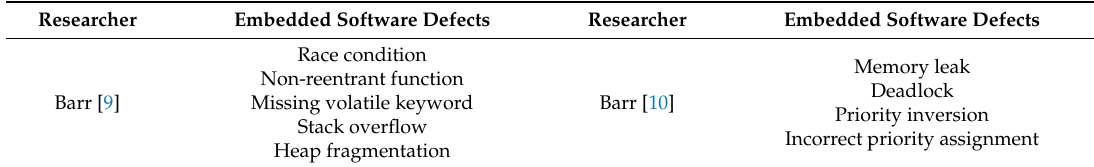
Table 5. Embedded software defects and